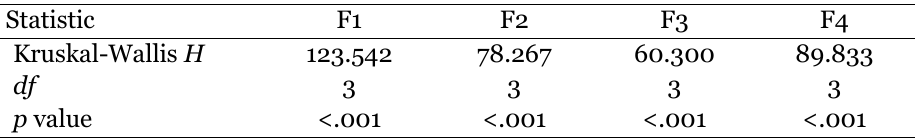
Tests Factor Score Variation Across Latent